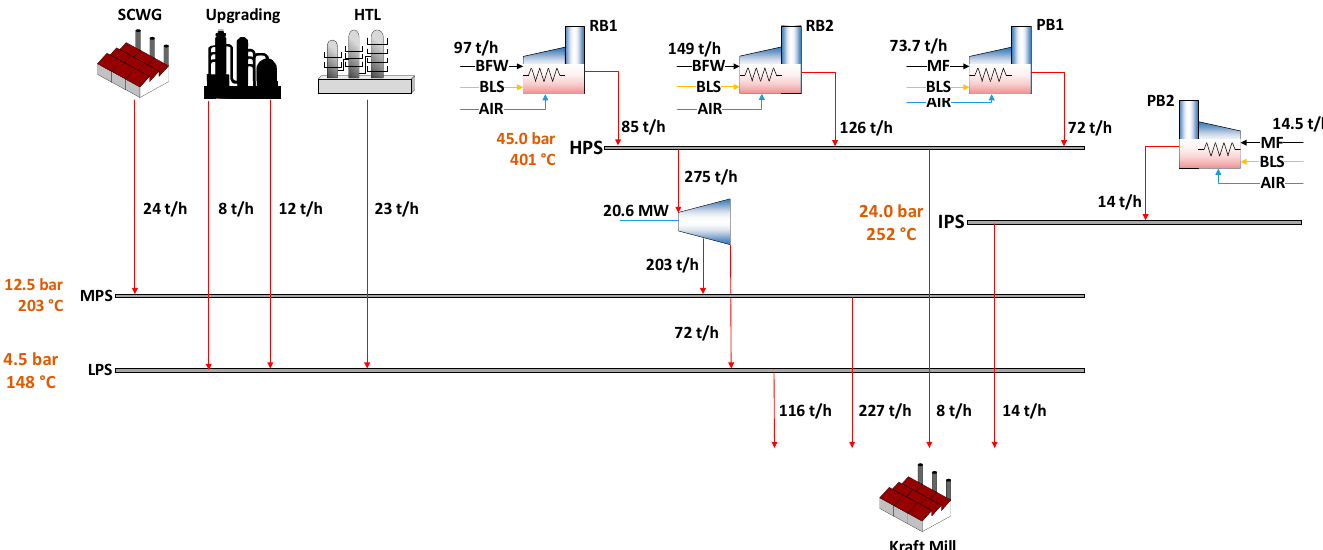
Figure 3. Simplified utility system of integrating the hydrothermal liquefaction process with the existing kraft mill.